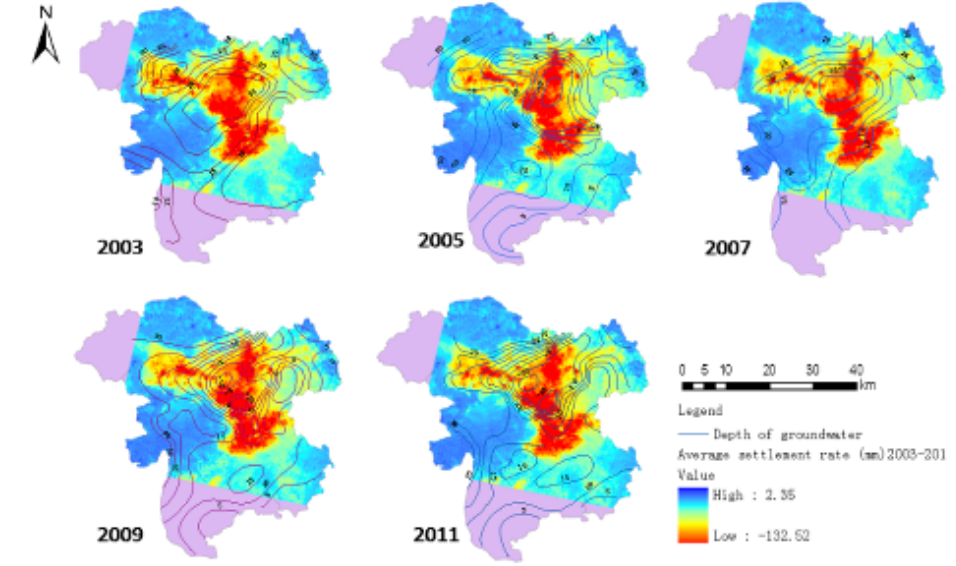
Figure 5. Groundwater contours (depth to water) and land